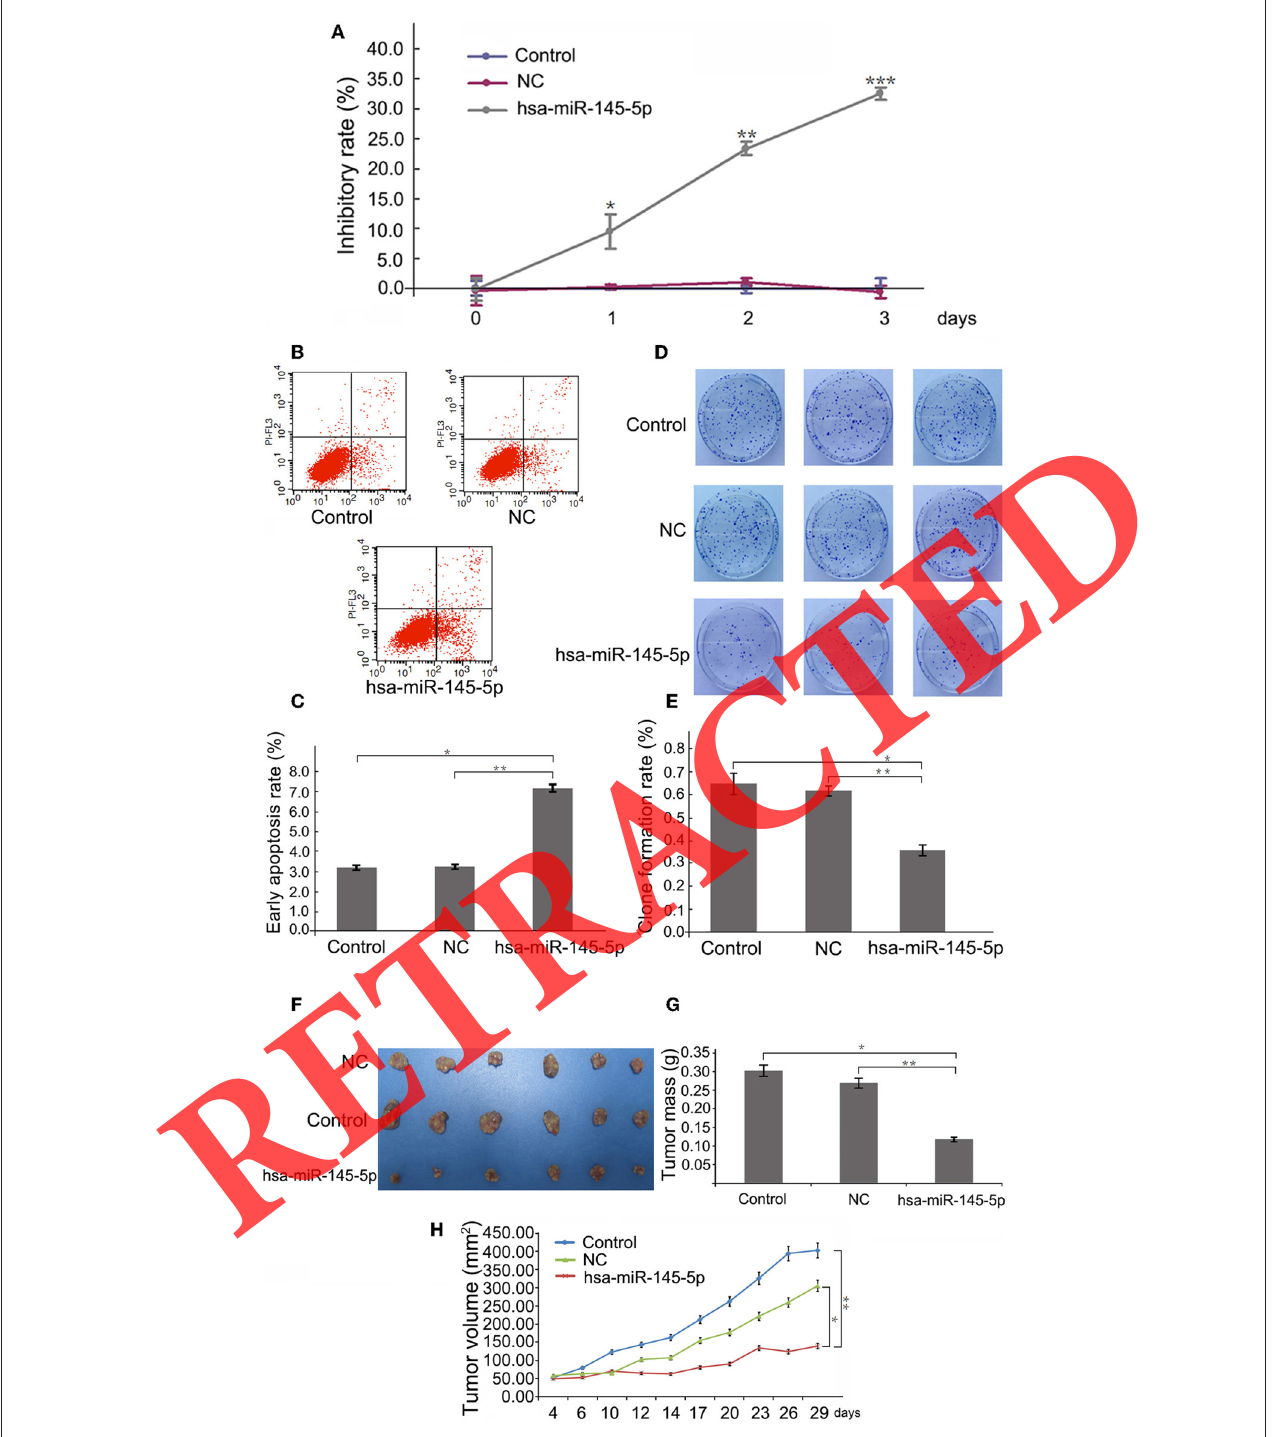
FIGURE 2 | Effects of miR-145-5p overexpression on the proliferation and apoptosis of LNCaP cells. (A) The inhibitory rate of proliferation was detected by a CCK-8 assay; * P < 0.05, ** P < 0.05, *** P < 0.01 compared with the NC group. (B) Cells undergoing early apoptosis were detected by annexin V/PI double staining. (C) Early cell apoptosis rate; * P < 0.05, ** P < 0.05 compared with the NC and control groups. (D) Cell clonogenic ability was evaluated by a clone formation assay. (E) Cell clone formation rate; * P < 0.05, ** P < 0.05 compared with the NC and control groups. (F) Tumor formation in nude mice. (G) Photographs of tumors from each group. (H) Tumor volume growth curve of each group of nude mice; * P < 0.01, ** P < 0.05 compared with the NC and control groups.